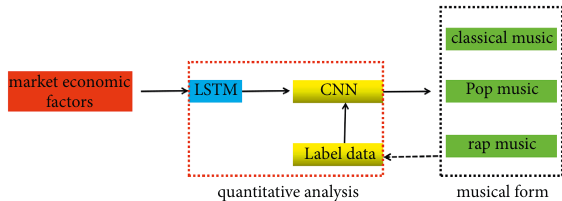
Figure 1: Scheme design of quantitative analysis of market economy scale and music innovation form.